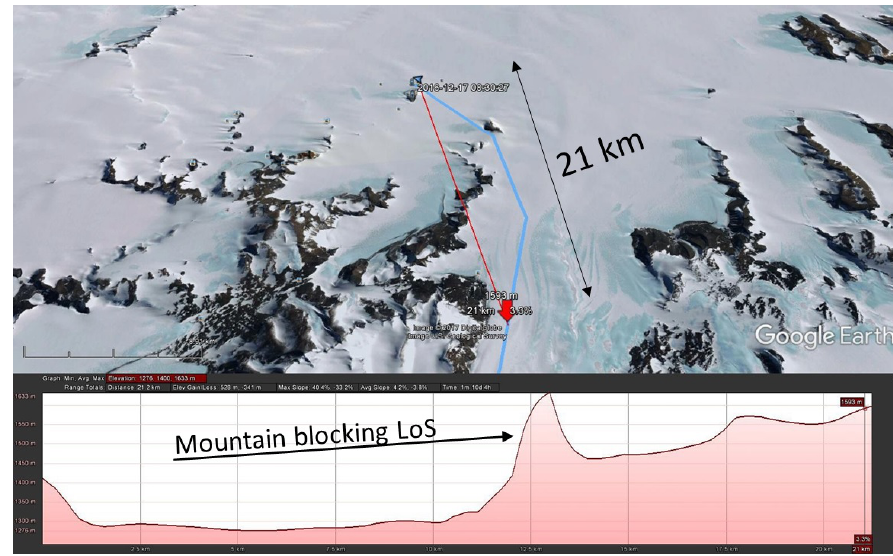
Figure 13. Scenario where NLoS propagation was detected. The location where the transmission took place is indicated on the map.